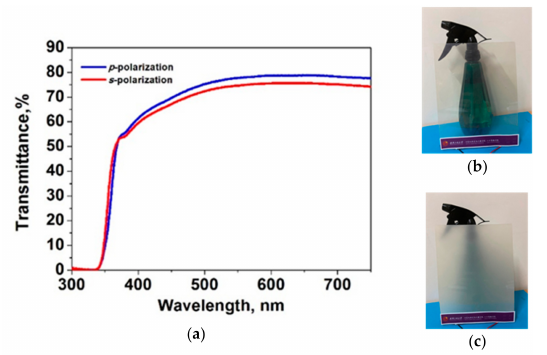
Figure 4. ( a ) Transmittance measurements for p-polarized (blue) and s-polarized (red) at the hori- zontal viewing angle 70 ◦ under 5 V rms applied voltage; ( b ) PDLC film at 10 V rms applied voltage; ( c ) PDLC film at 0 V rms applied